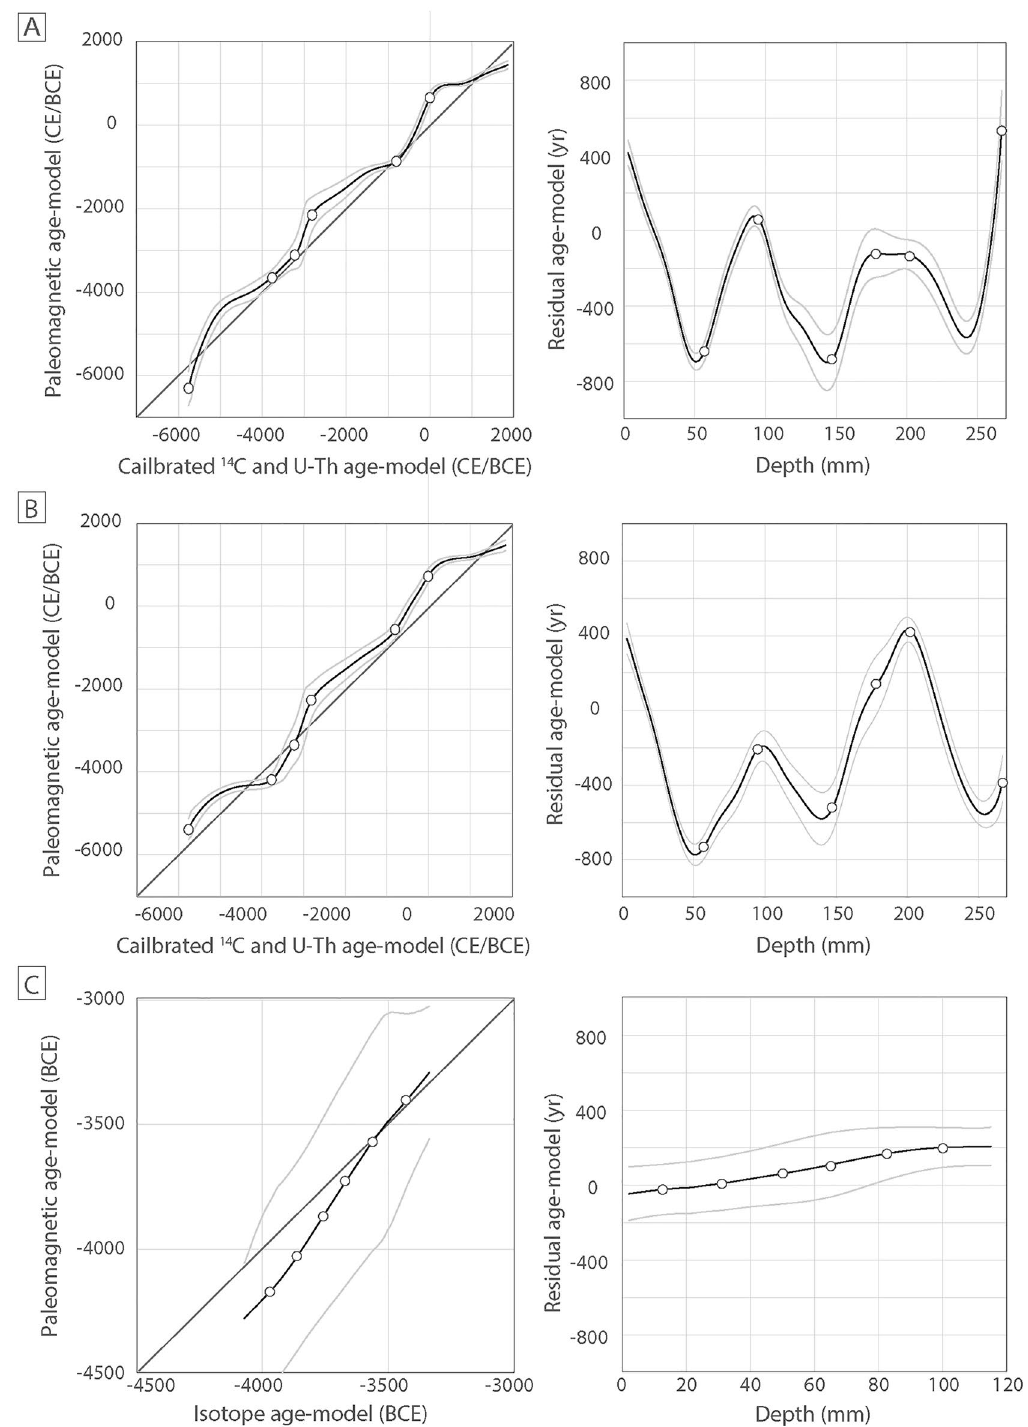
Figure 5. Correlation between the age-depth model obtained by calibrated 14 C and U-series isochrons (cf. Fig. 4A) and the model based on the comparison between the SP paleomagnetic data and the PSV curves from ( A ) the SHA.DIF.14k model, and ( B ) the pfm9k model (cf. Fig. 4B,C). Opened circles correspond to the calibrated 14 C and U–Th dating (see Table 1). The confidence intervals are calculated based on the paleosecular variation age model only and are plotted at 95% of probability. ( C ) Equal correlation performed on SPAIV speleothem 26 with paleomagnetic data fitted to the PSV curve obtained with